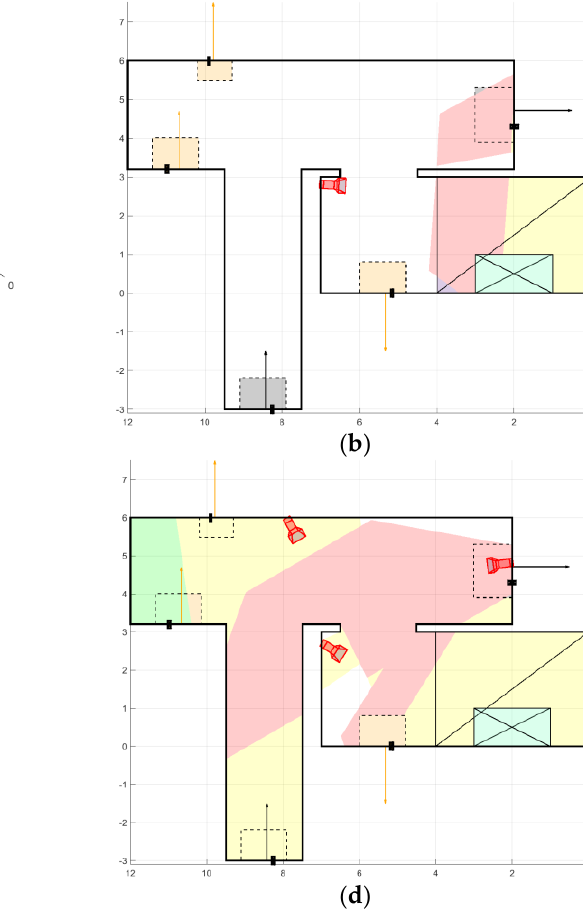
Figure 11. Function values for different number of cameras, room 2.